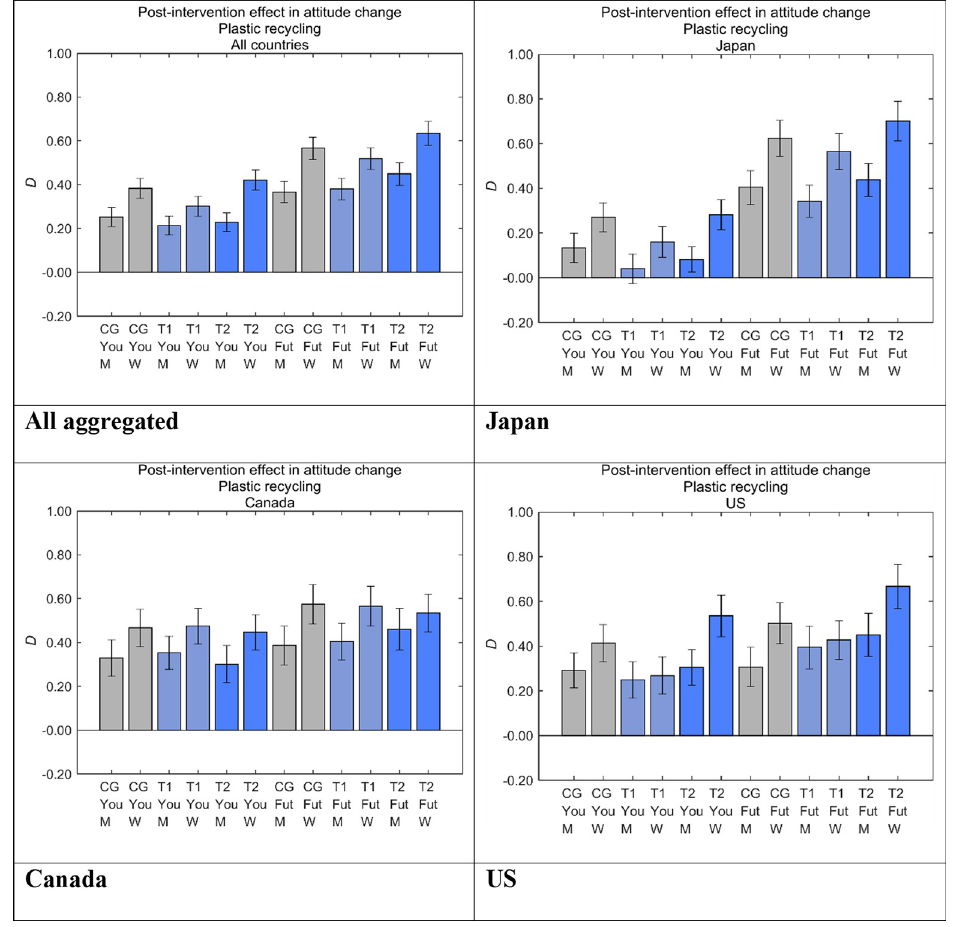
Fig 14. Post-intervention effect in attitude change toward disposable plastics ( D ) by sex. Error bars show 95% confidence intervals. Higher values on the vertical axis indicate lower perceived danger of plastic recycling. CG, control group; T1, treatment group 1; T2, treatment group 2; Fut, Future Generations; You, Yourself; M, men; W,